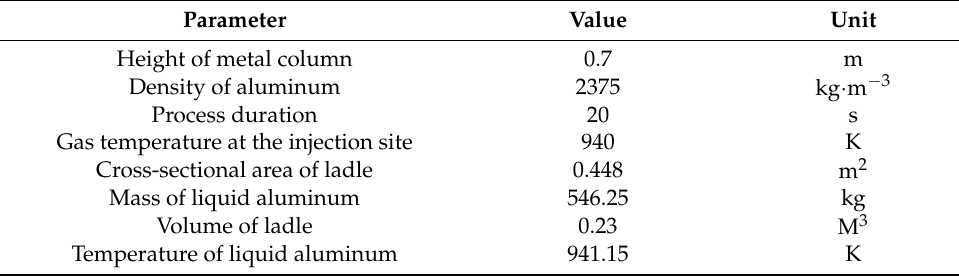
Table 4. Data for calculating mixing power introduced by an inert gas.